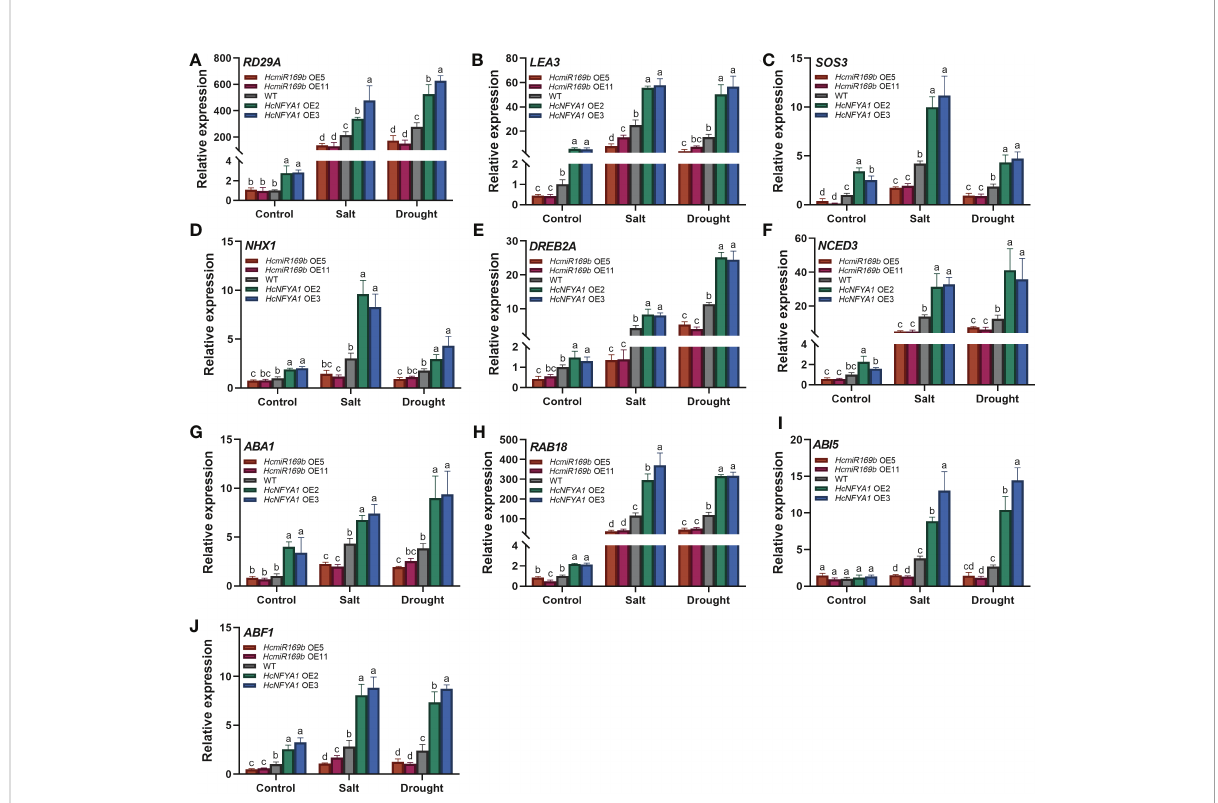
FIGURE 6 Expression of downstream stress-responsive genes in WT and two transgenic ( HcmiR169b , HcNFYA1 OE) Arabidopsis under salt and drought stress. (A-J) The relative expression levels of RD29A (A) , LEA3 (B) , SOS3 (C) , NHX1 (D) , DREB2A (E) , NCED3 (F) , ABA1 (G) , RAB18 (H) , ABI5 (I) and ABF1 (J) in adult Arabidopsis under the control, salt (300 mM NaCl) and drought (20% PEG6000) stress. All data represented the means ± SD of three biological replicates. Different letters indicated signi fi cant differences in the detected values of various types of Arabidopsis between treatments (Duncan ’ s multiple range test, p